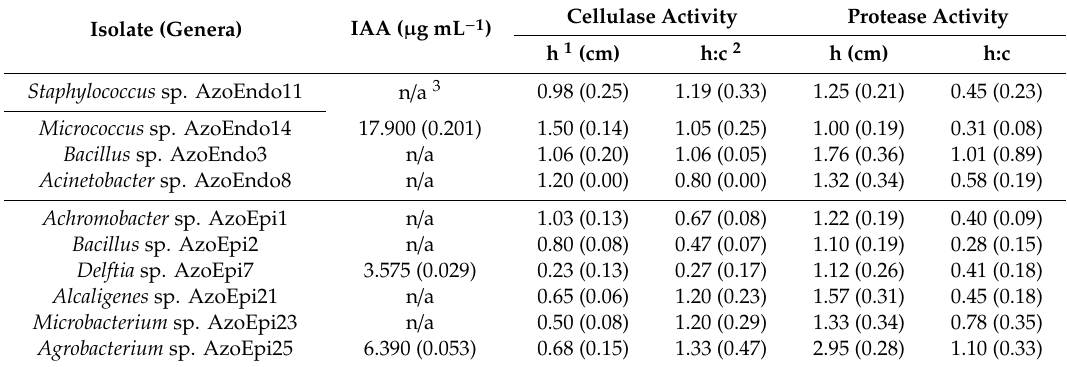
Table 4. Levels of IAA as well as cellulase and protease activities of the isolates studied (means ± SD). Isolate